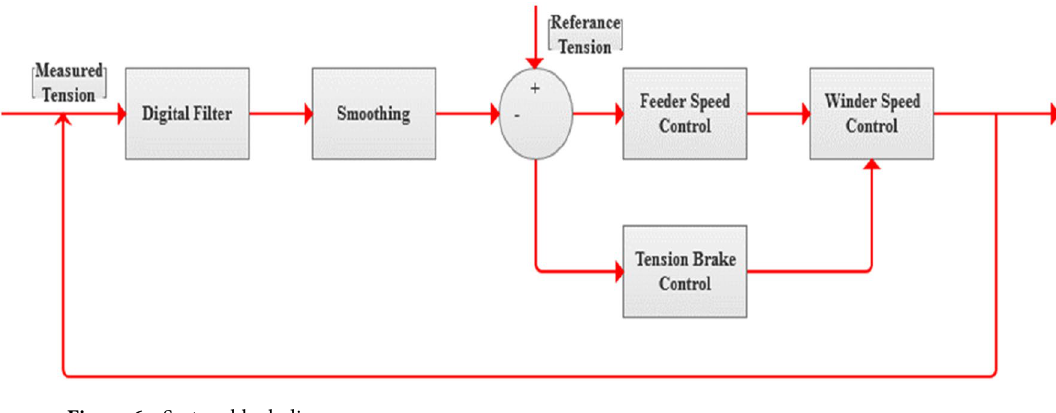
Figure 6. System block